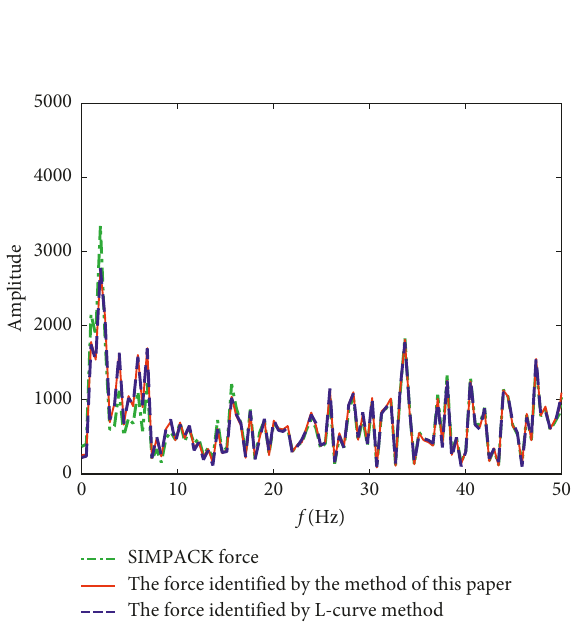
Figure 31: Amplitude-frequency curve of the two methods for F 2 identification when the noise level is 0%.